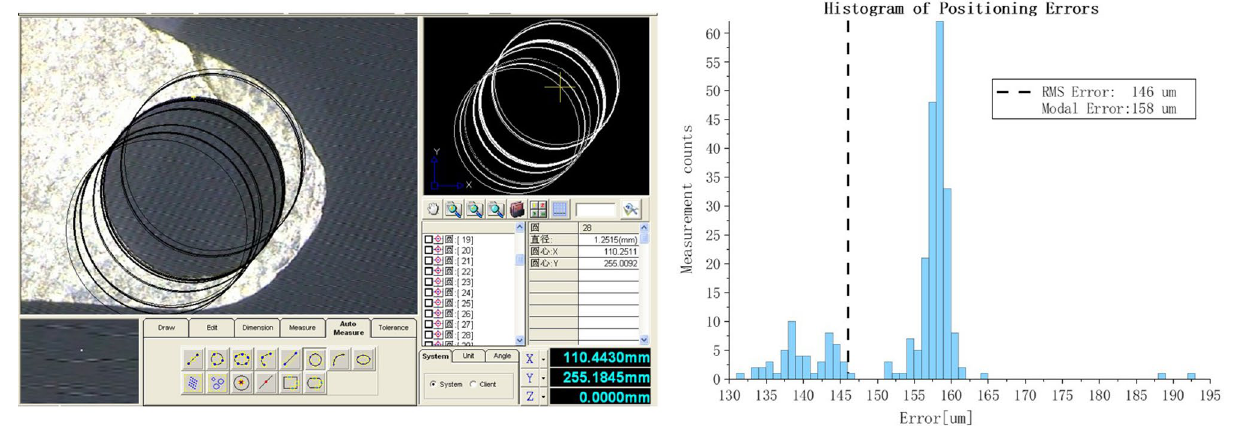
Figure 20. Positioning experiment